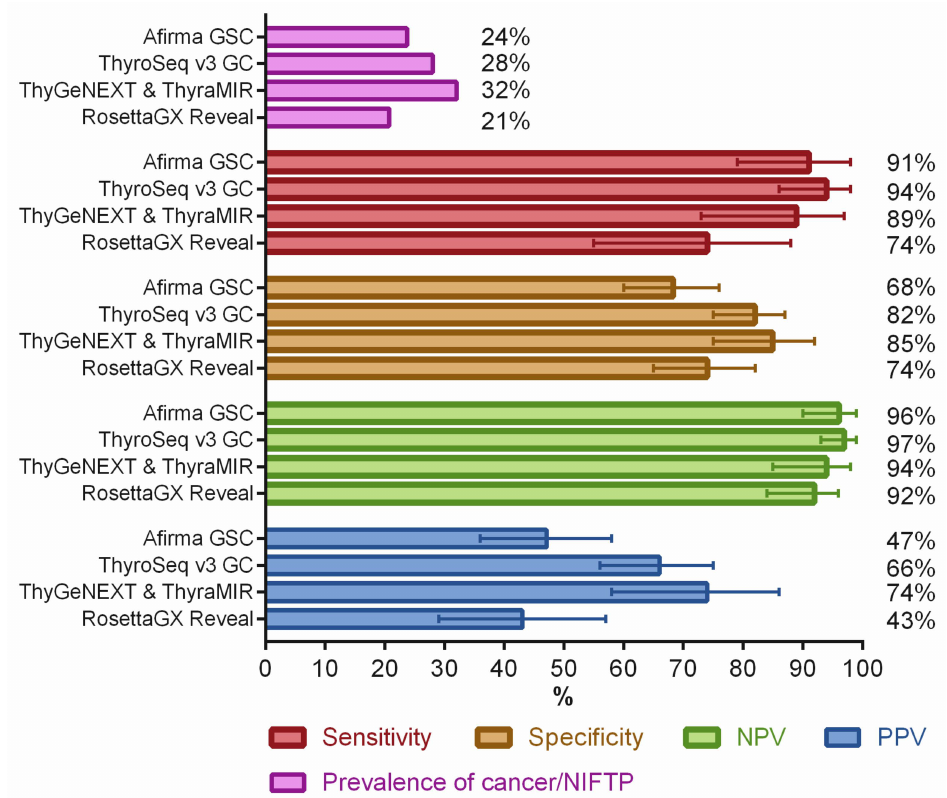
Figure 3. Diagnostic performance of commercially available molecular panels for thyroid nodules with indeterminate FNA cytology (atypia of undetermined significance/follicular lesion of undeter- mined significance and follicular neoplasm/suspicious for a follicular neoplasm). The length of the error bars is a 95% confidence interval. These data were obtained from clinical validation studies of Afirma Gene Sequencing Classifier (GSC) [118], ThyroSeq v3 Genomic Classifier (GC) [119], Thy- GeNEXT and ThyraMIR [117], and RosettaGX Reveal [120]. NIFTP, non-invasive follicular thyroid neoplasm with papillary-like nuclear features; NPV, negative predictive value; and PPV, positive predictive